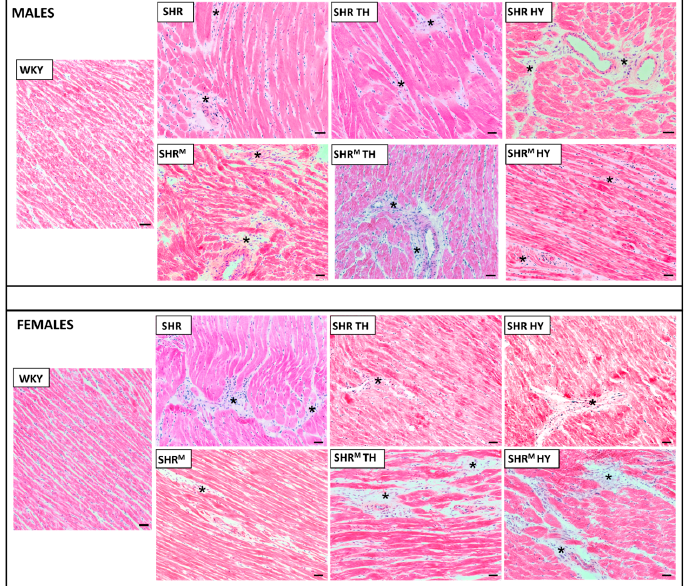
Figure 1. Hematoxylin–eosin staining revealed the infiltration of polymorphonuclears (asterisks) in all SHR groups. WKY—Wistar Kyoto normotensive control rats, SHR—wild type spontaneously hypertensive rats, TH—hyperthyroid rats, HY—hypothyroid rats and SHR M —hairless spontaneously hypertensive rats, n = 5 per group. Scale bar represents 200 μ m.